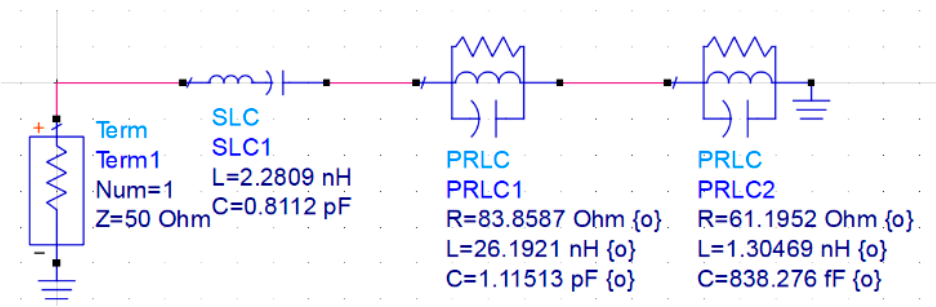
Figure 2 . Antenna equivalent circuit based on impedance data. Figure 2. Antenna equivalent circuit based on impedance